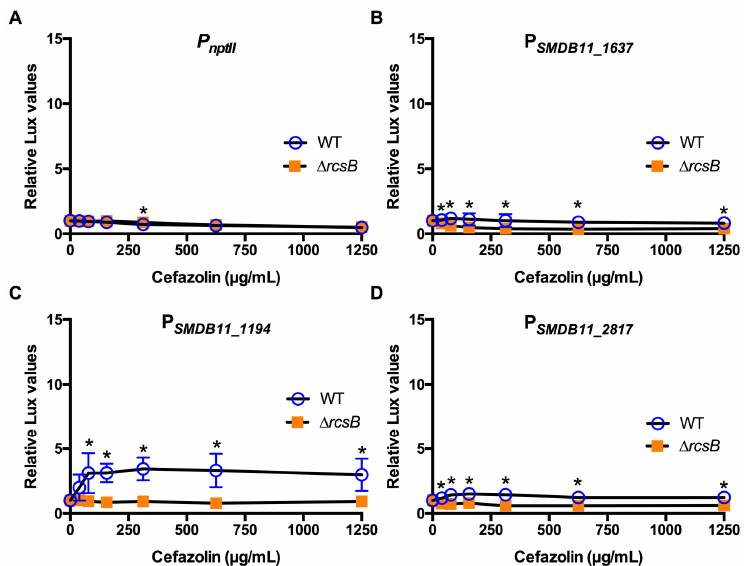
Figure 4. Effect of cell wall activating cefazolin on Rcs-activated promoters ( A – D ). Relative luminescence values were determined by dividing luminescence by optical density after 4 h of antibiotic challenge. The nptII promoter ( A ) was unaffected by cefazolin. Only the Rcs-dependent SMDB11_1194 promoter ( C ) was activated to a greater extent in the WT than the Rcs-defective ∆ rcsB mutant. Mean and standard deviation are shown ( n = 6–9 are shown). Asterisks (*) indicate statistical differences between groups at the indicated concentrations, p < 0.05.